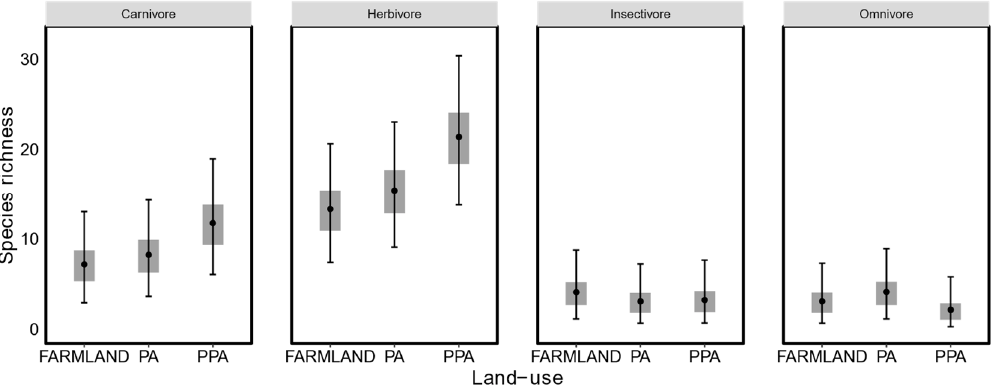
Figure 3. Estimated mammalian (>0.5 kg) species richness for each functional guild in the small- livestock farmland (Farmland), protected area (PA), and private protected area (PPA) (black dots: mean, grey boxes: 50% BCI, and black bars: 95% BCI).